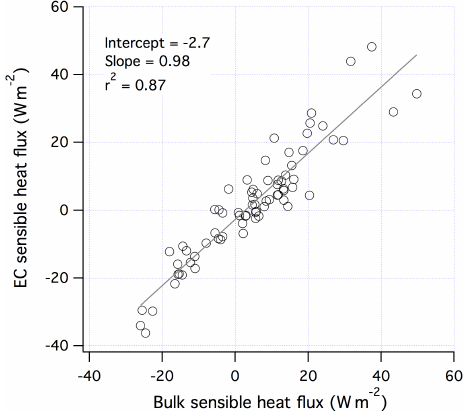
Figure A3. Measured vs. predicted sensible heat flux for the air– water wind